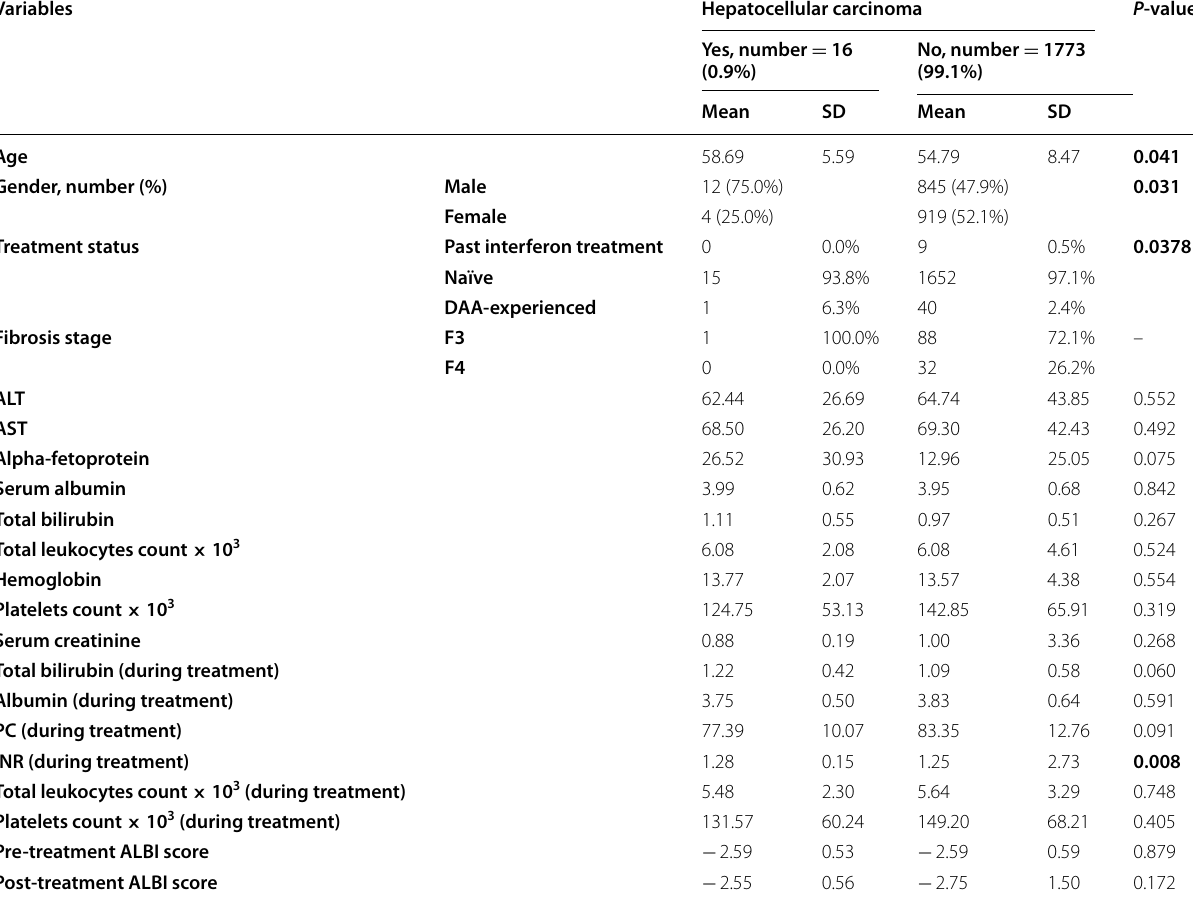
Table 5 Demographic and laboratory features of the studied patients according to the occurrence of de novo HCC (total 1789) Variables